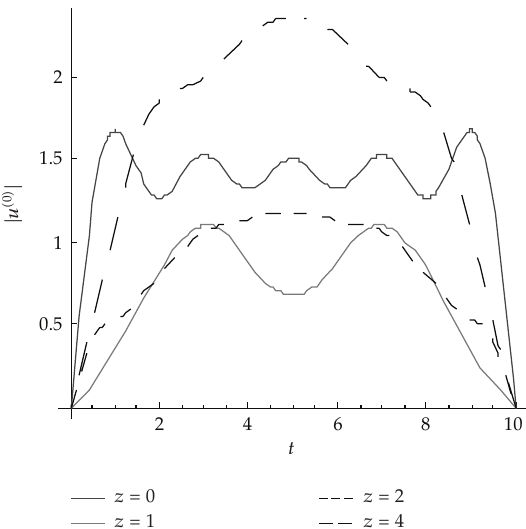
Figure 17: The zero-order approximation | u (cid:3) 0 (cid:4) | at α (cid:8) 1, T (cid:8) 10, γ (cid:8) 02 for di ff erent values of z , considering only one term in the series (cid:3) M (cid:8) 1 (cid:4)